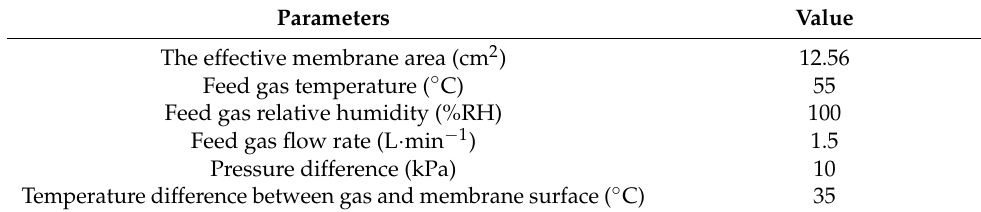
Table 4. Solubility parameters of ECTFE and diluents